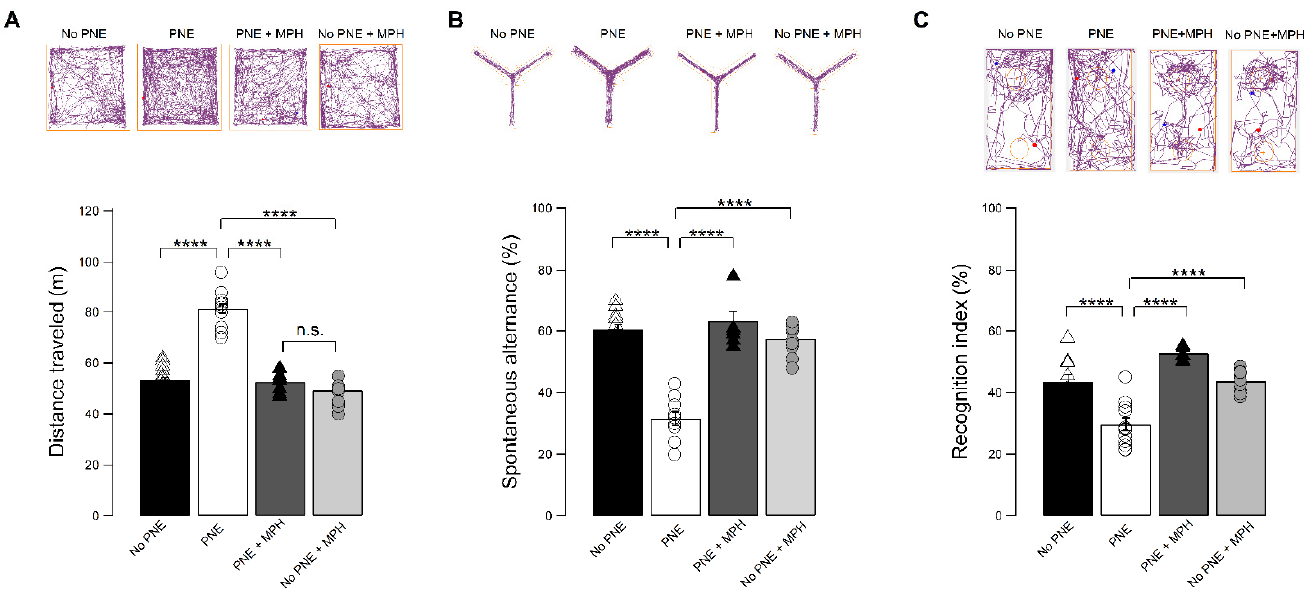
Figure 1. Single MPH administration reverts abnormal behaviors in PNE mice. ( A ) Overall distance traveled (mean ± SEM) for each experimental group in an open field test. PNE mice display enhanced locomotor activity referred to control (no − PNE) mice. (PNE:81.33 ± 1.75 m, n = 15; no − PNE: 53.33 ± 1.0 m, n = 20; two-way ANOVA F (3,27) = 74.41, **** p < 0.0001, followed by Tukey post hoc test). MPH-treated PNE and no − PNE mice do not differ in their spontaneous motor activity (no − PNE: 53.332 ± 1.0 m, n = 20; PNE + MPH: 49.26 ± 1.34 m, n = 10, p > 0.05). Inset: Sample traces associated with spontaneous locomotor activity for each group of mice during an open field test trial. ( B ) Percentage of spontaneous alternation (mean ± SEM) evaluated in a Y-maze test for the four experimental groups. Spontaneous alternation in PNE mice is about half referred to control no − PNE mice (PNE: 31.50 ± 2.15, n = 10; no − PNE: 60.47 ± 1.70, n = 15; two-way ANOVA F (3,27) = 48,91; **** p < 0.0001). MPH-treated PNE and no − PNE mice show no significant difference in their spontaneous alternation (no − PNE: 60.47 ± 1.70, n = 15; PNE + MPH: 57.40 ± 1.58, n = 10; **** p < 0.0001). Inset: Sample traces associated to locomotor activity for each group of mice during a Y-maze test trial. ( C ) Plot showing the percentage of recognition index evaluated in object-based attention test for the four experimental groups. The percentage is significantly lower in PNE mice compared to control no − PNE mice (PNE: 29.68 ± 2.07, n = 12; no − PNE: 43.48 ± 2.39, n = 11; two-way ANOVA F (3,24) = 23,65; **** p < 0.0001). There is no significant difference in recognition index between MPH-treated PNE mice and no − PNE (PNE + MPH: 43.72 ± 1.17, n = 10; no − PNE: 43.48 ± 2.39, n = 11; p > 0.05). Inset: Sample traces associated to locomotor activity for each group of mice during retention phase of OBA test. The red dot inside the chamber area represents the new object.